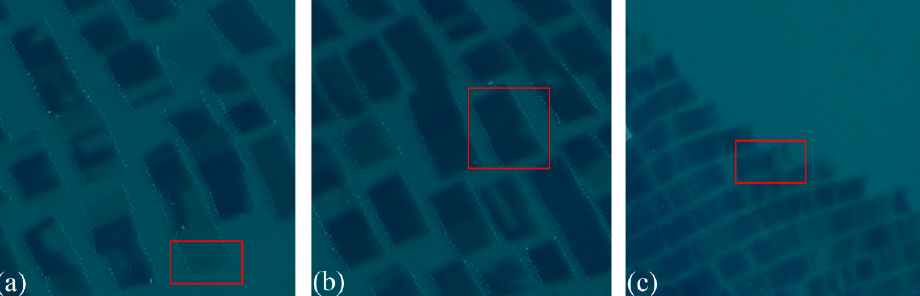
Figure 4. Floating raft aquaculture areas (imaged on November 2013) by GF-1. ( a ) The first type (area in red box). ( b ) The second type (area in red box). ( c ) The third type (area in red box).